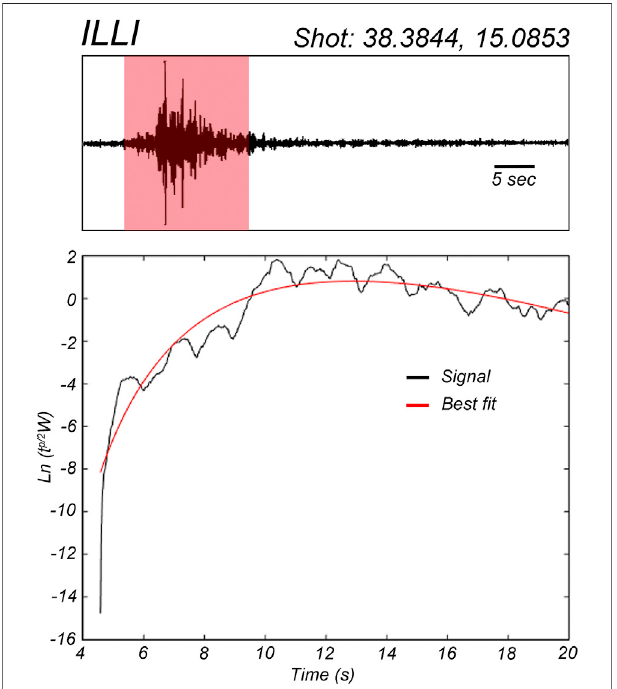
FIGURE 3 | Comparison of best fi ts between the data and model for an example seismogram recorded on the island of Lipari (see Figure 2 ).